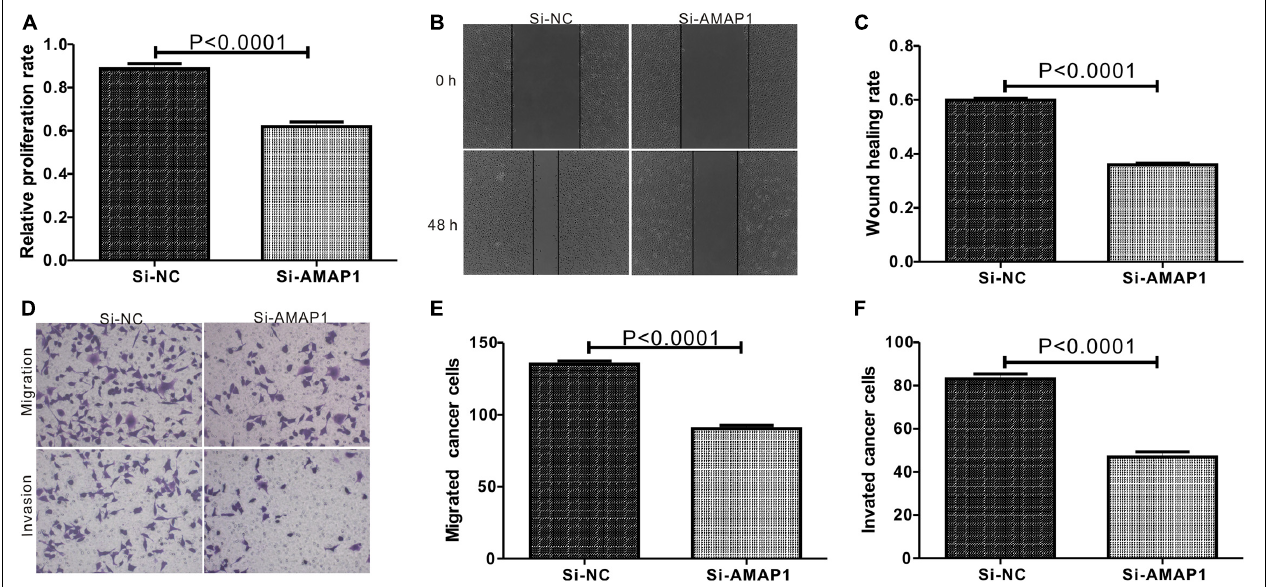
FIGURE 9 | The effects of knocking out AMAP1on the cell proliferation, migration and invasion. Silence of AMAP1 exhibited lower cell proliferative rate than that in control group as revealed by CCK-8 assay (A) . Wound healing test revealed that silence of AMAP1exhibited lower wound healing rate than that in control group (B,C) . Transwell assay demonstrated that silence of AMAP1 showed lower migration and invasion ability than that in control group (D–F)